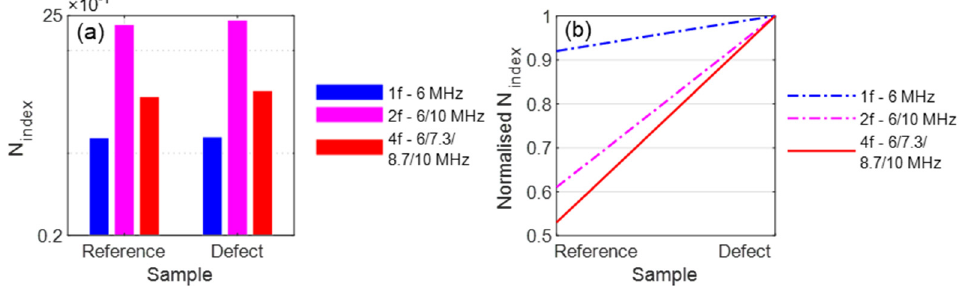
Figure 7. Evaluation: ( a ) N index ; ( b ) Normalised N index .